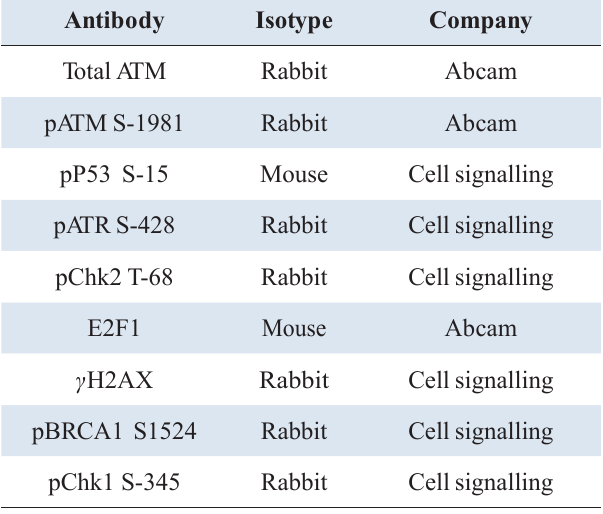
Table 3. Primary Antibodies used in the